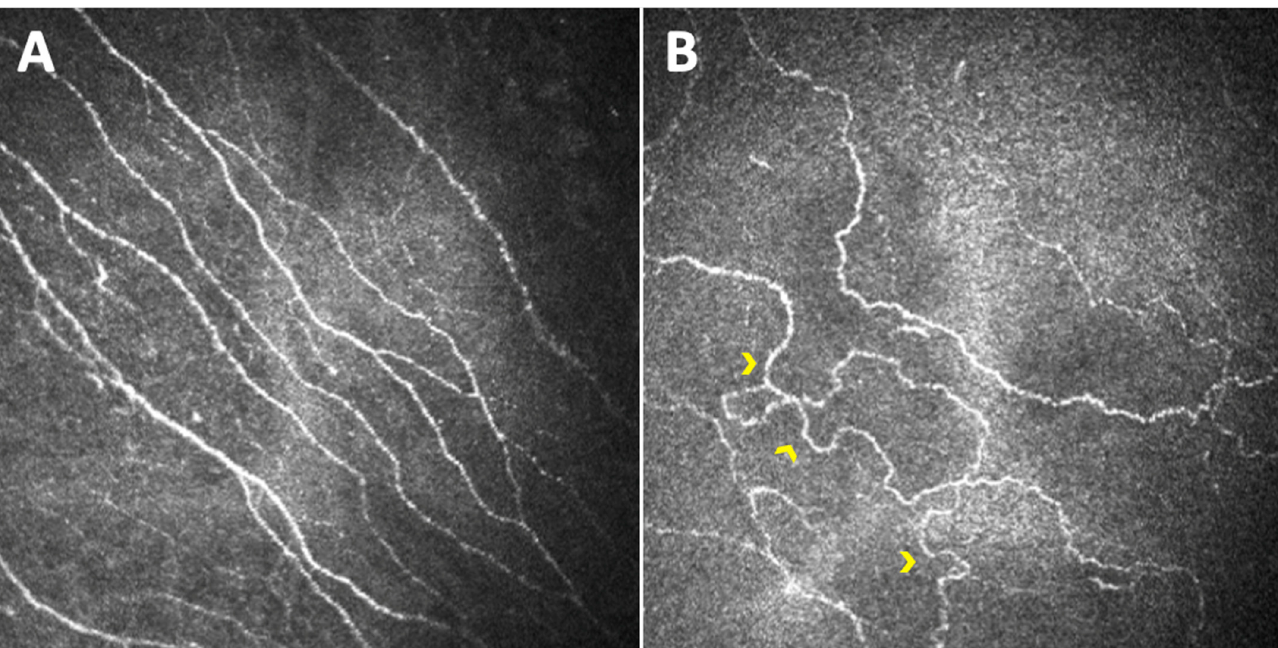
Figure 2. Images of the sub-basal nerve plexus captured with Heidelberg Retina Tomograph III Rostock Corneal Module (Heidelberg, Germany) from the central cornea of a healthy subject ( A ) and a diabetic subject with diabetic peripheral neuropathy ( B ). While the corneal nerve fibers of the healthy subject are mostly straight, those of the diabetic neuropathic patient show increased tortuosity (yellow arrowheads).